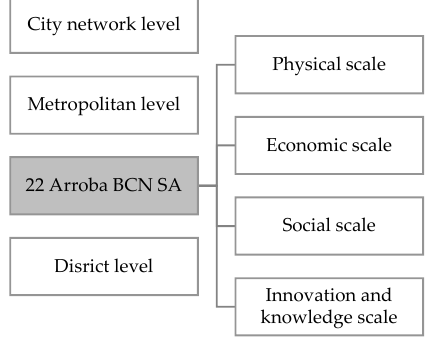
Figure 4. Arroba BCN SA as a bridging organization .